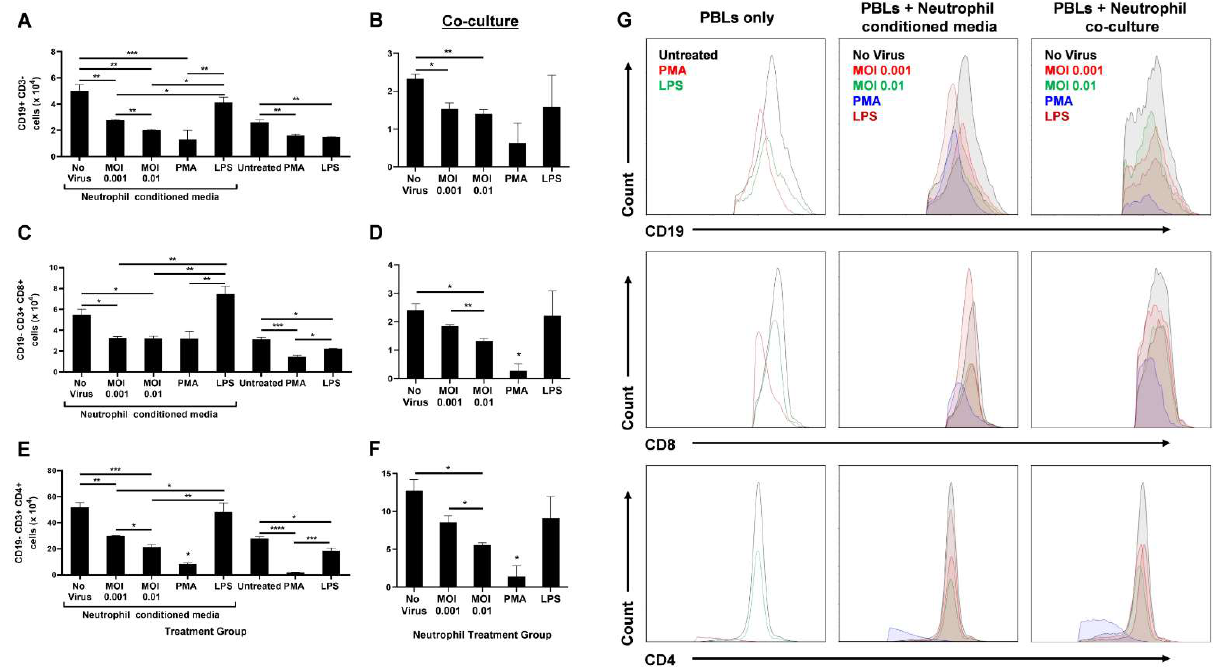
Figure 3. SARS-CoV-2-infected neutrophils reduce lymphocyte counts in vitro. After 18 h treatment of PBLs with conditioned media from infected neutrophils or direct stimulation with PMA or LPS, the number of CD19+ CD3- B cells ( A ), CD19 − CD3+ CD8+ T cells ( C ), and CD19 − CD3+ CD4+ T cells are shown ( E ). Following 18 h coculture of PBLs with infected neutrophils, the number of CD19+ CD3- B cells ( B ), CD19- CD3+ CD8+ T cells ( D ), and CD19- CD3+ CD4+ T cells are shown ( F ); ( G ) Representative flow cytometry histograms of B and T cells in different treatment groups of PBLs alone, PBLs treated with neutrophil-conditioned media, and PBL/neutrophil co-culture. Data shown are mean ± SEM; n = 3 per group in each experiment per donor; experiments were repeated three times with three different donors; * p < 0.05, ** p < 0.01, *** p < 0.001 (one-way ANOVA with Tukey’s post hoc test).